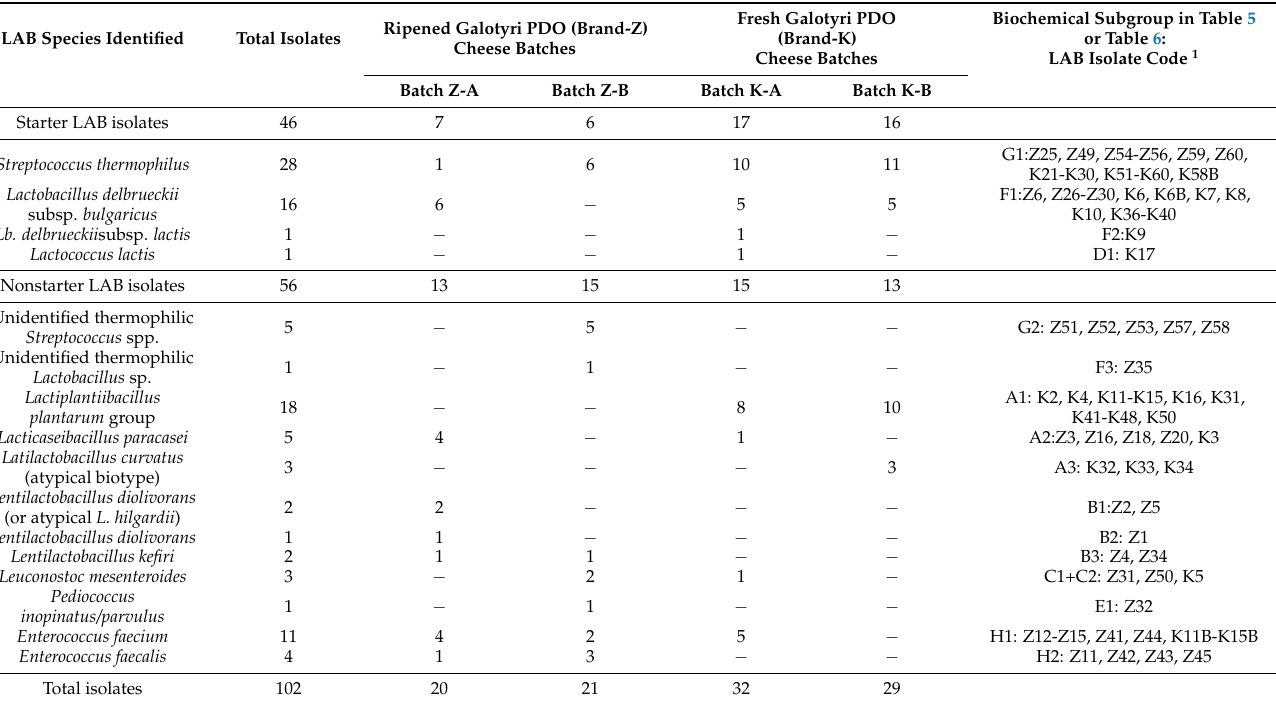
Table 7. Batch-dependent distribution of the 102 biochemically identified LAB isolates in the ripened